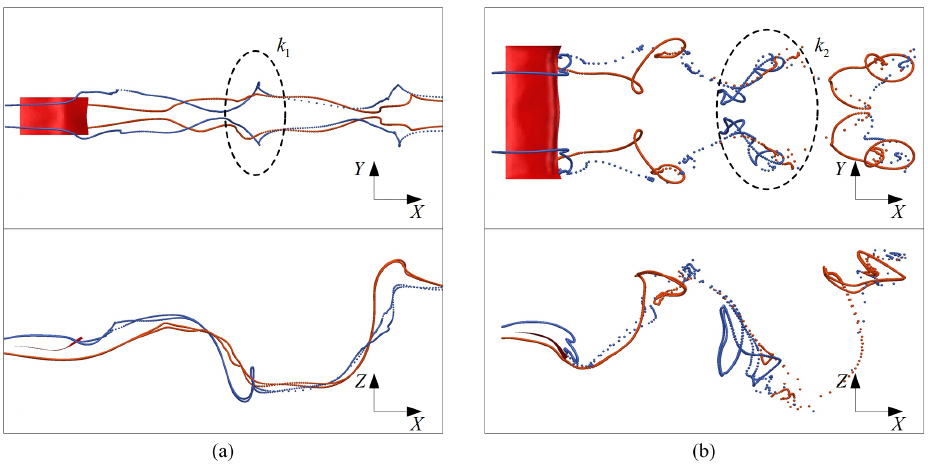
Figure 6. Snapshots of the tracing particles from the top and side view: ( a ) AR = 0.5; ( b ) AR = 2.0 (Supplementary Videos S2 and S3 are available online).